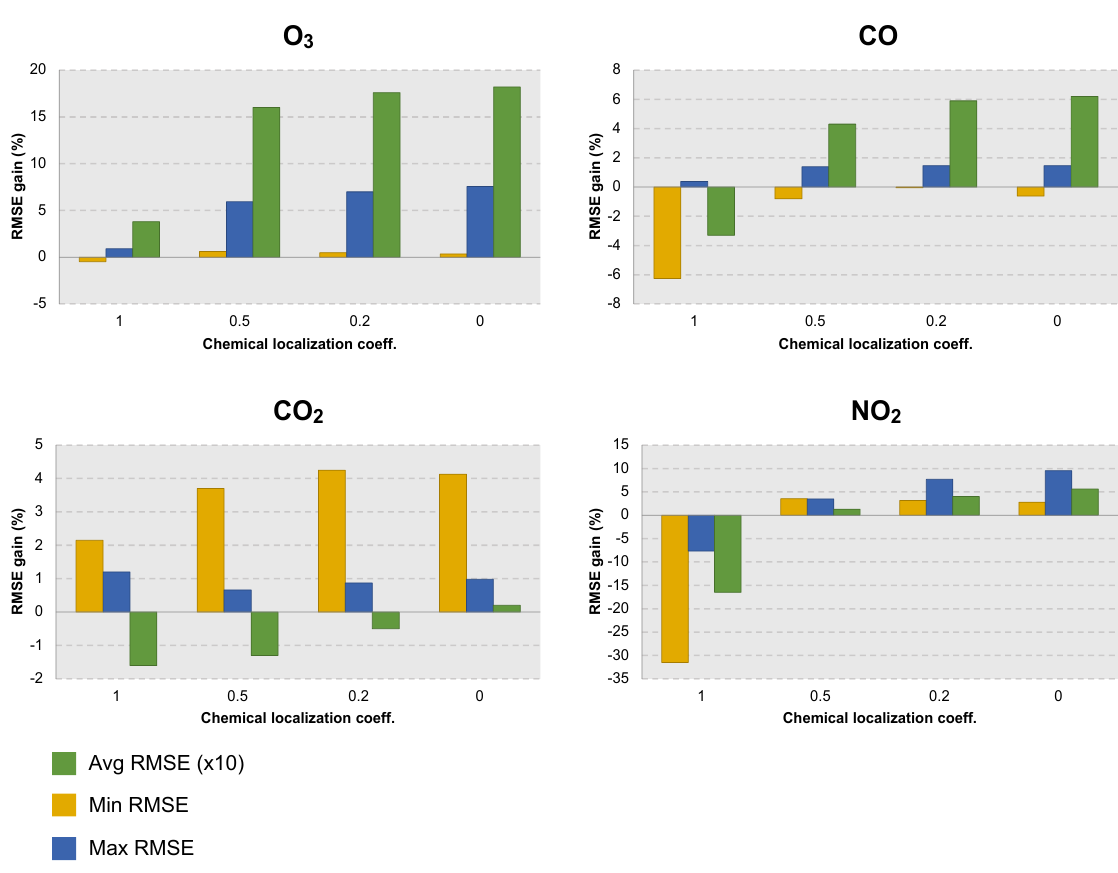
Figure 7. Same as Fig. 5 but for the multivariate correlation coefficient of the localization operator (with 0 corresponding to univariate DA and 1 to a full multivariate unlocalized